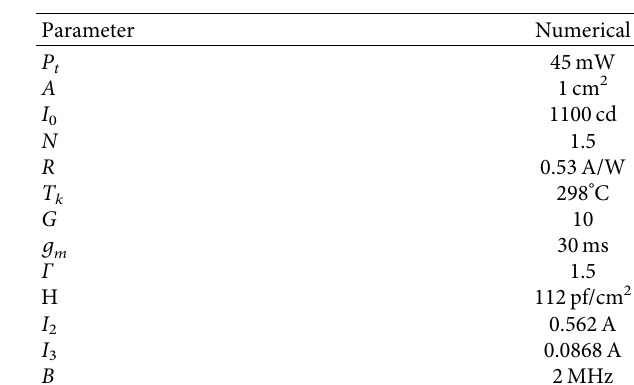
Table 1: Parameter table.